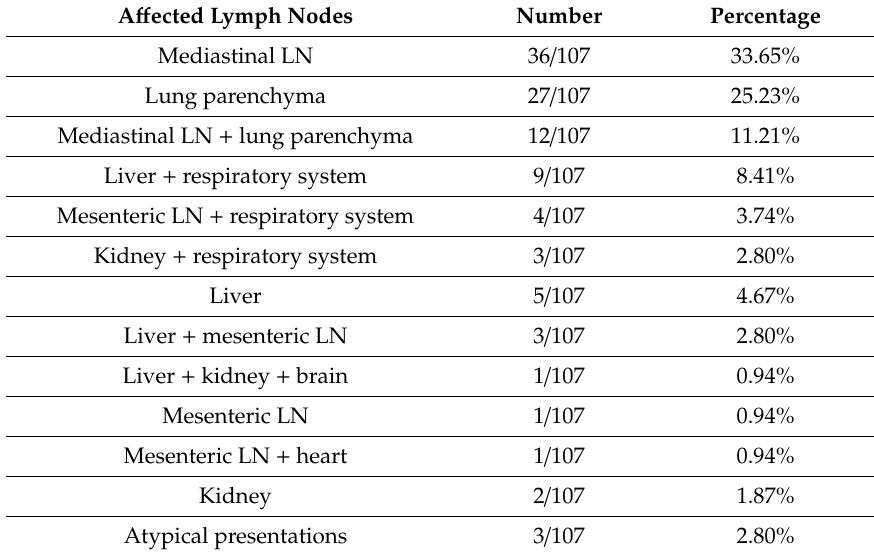
Table 3. Number and percentage of the a ff ected visceral lymph nodes (LN) and organs. A ff ected Lymph